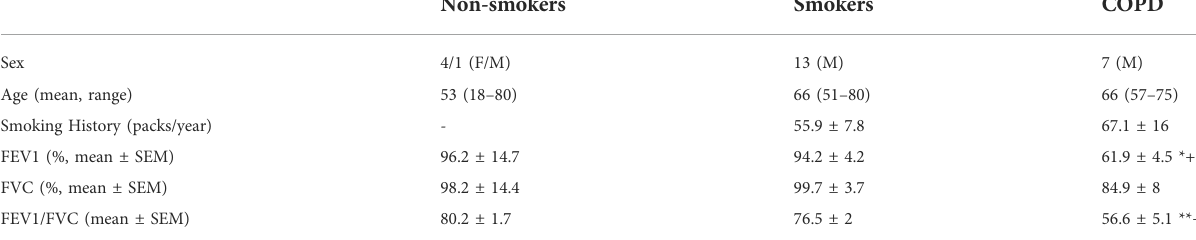
TABLE 1 | Demographics of